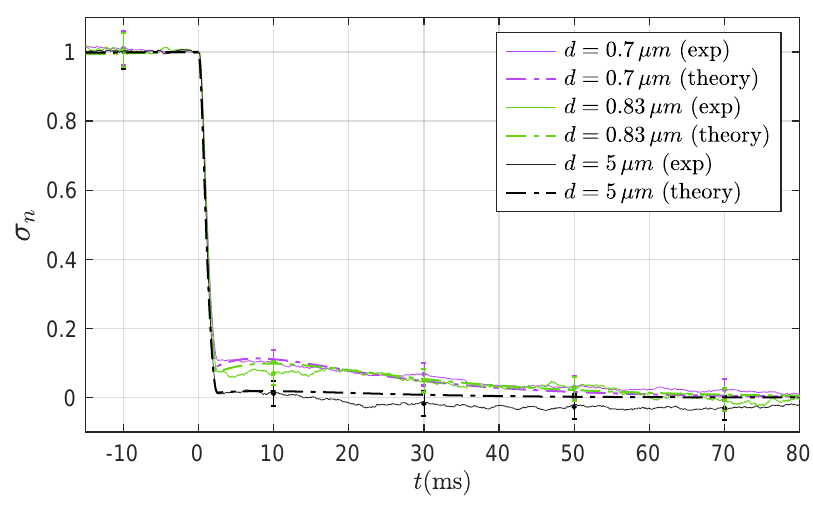
Figure 8: Same as Fig. 2 but with three distances: d = 5 µ m in black, d = 0.83 µ m in green and d = 0.7 µ m in